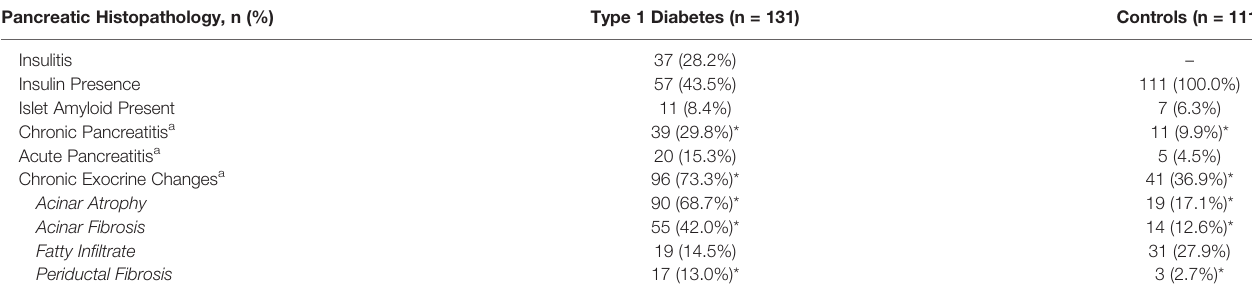
TABLE 2 | Pancreatic histopathologic changes. Pancreatic Histopathology, n (%)